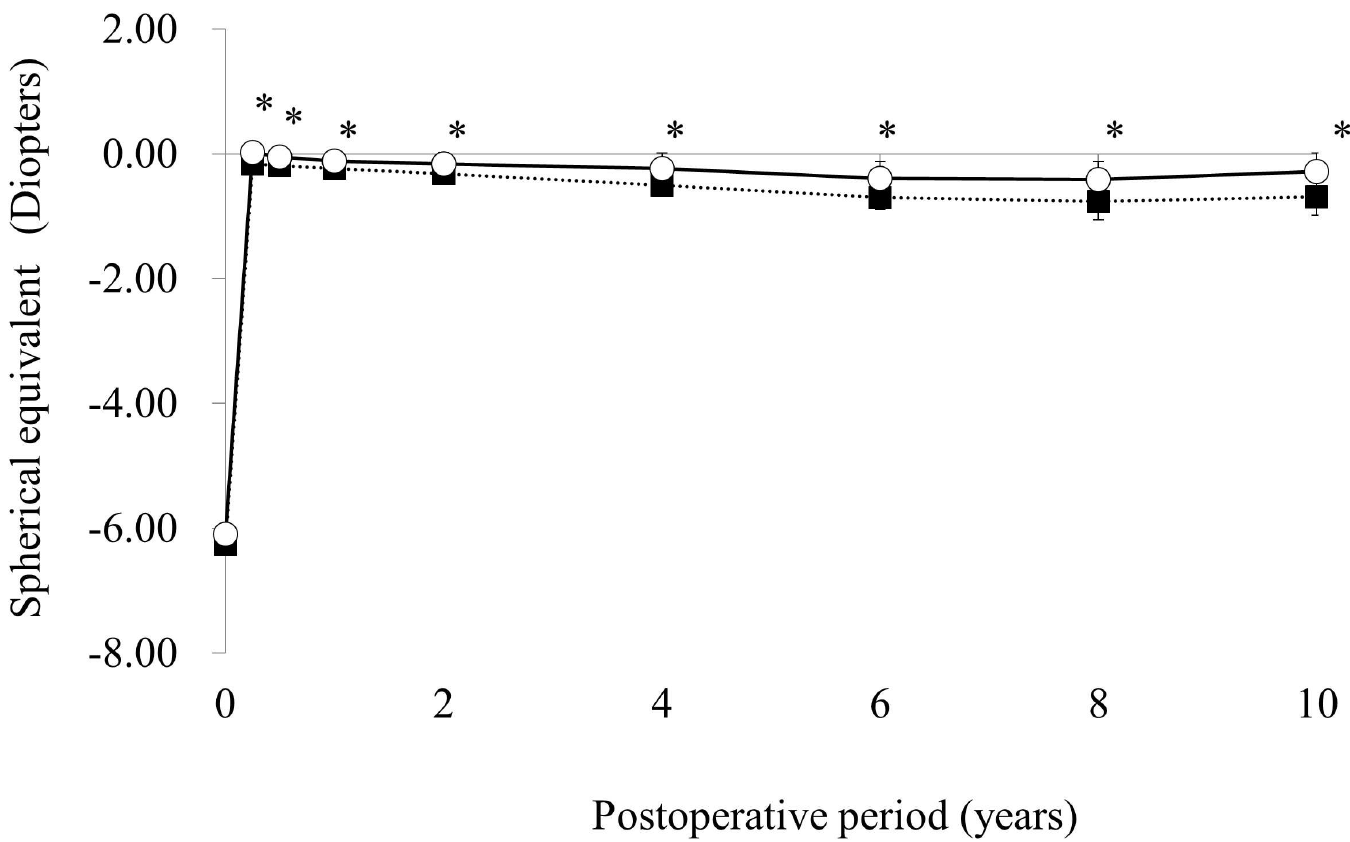
Fig 4. Time courses of the average and 95% confidence intervals of manifest refractivespherical equivalent in the laser in situ keratomileusis (closed square) and photorefractive keratectomy(open square) groups. * p < .05.